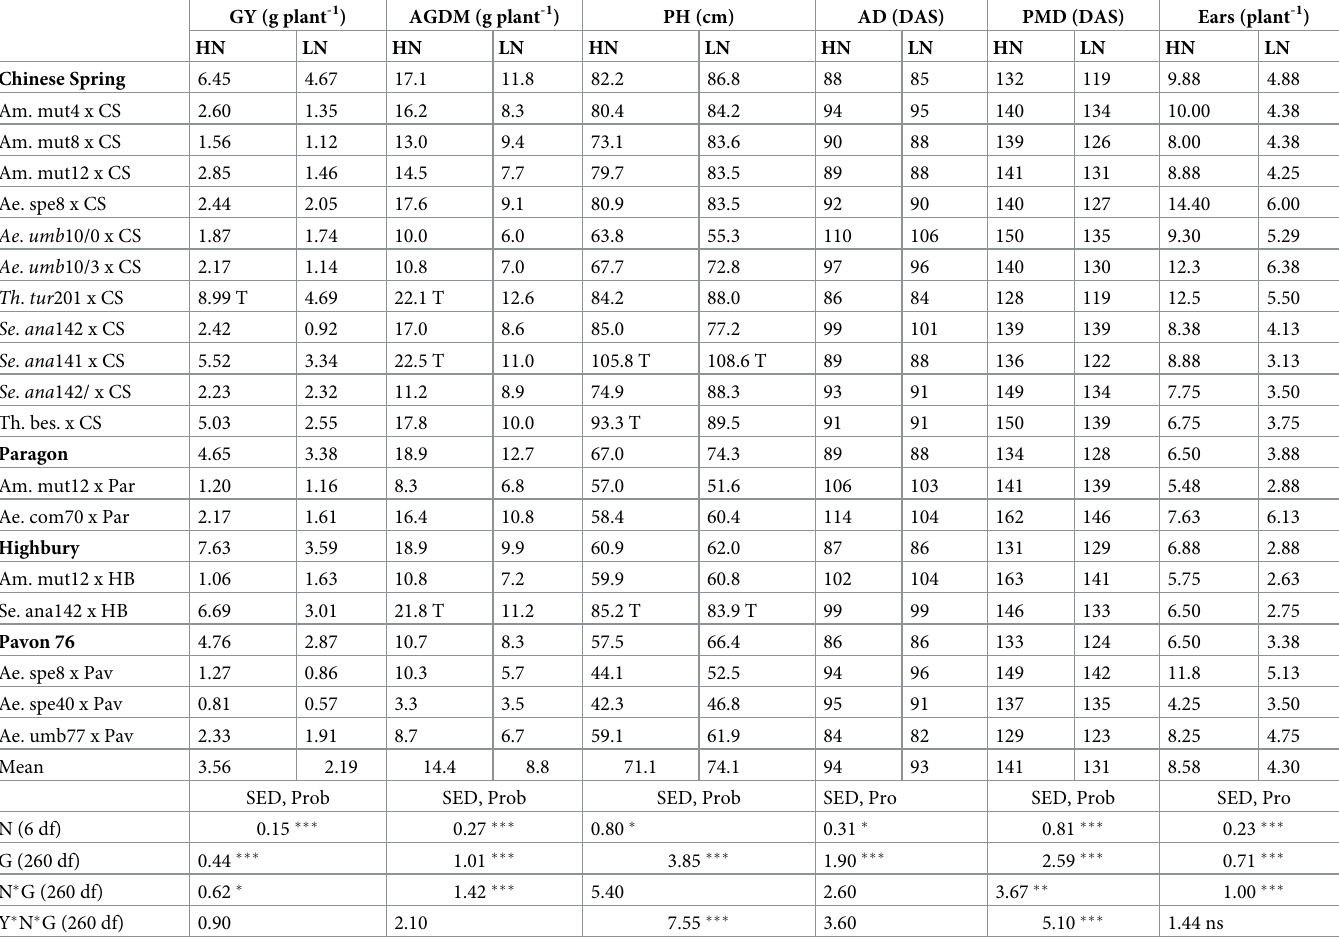
Table 2. Grain yield (GY) plant -1 , above-ground dry matter (AGDM) plant -1 , plant height (PH), anthesis date (AD), physiological maturity date (PMD) and ears plant -1 in 22 genotypes (18 amphidiploid lines and 4 bread wheat parents) under HN and LN conditions (mean 2015 and 2016). GY (g plant -1